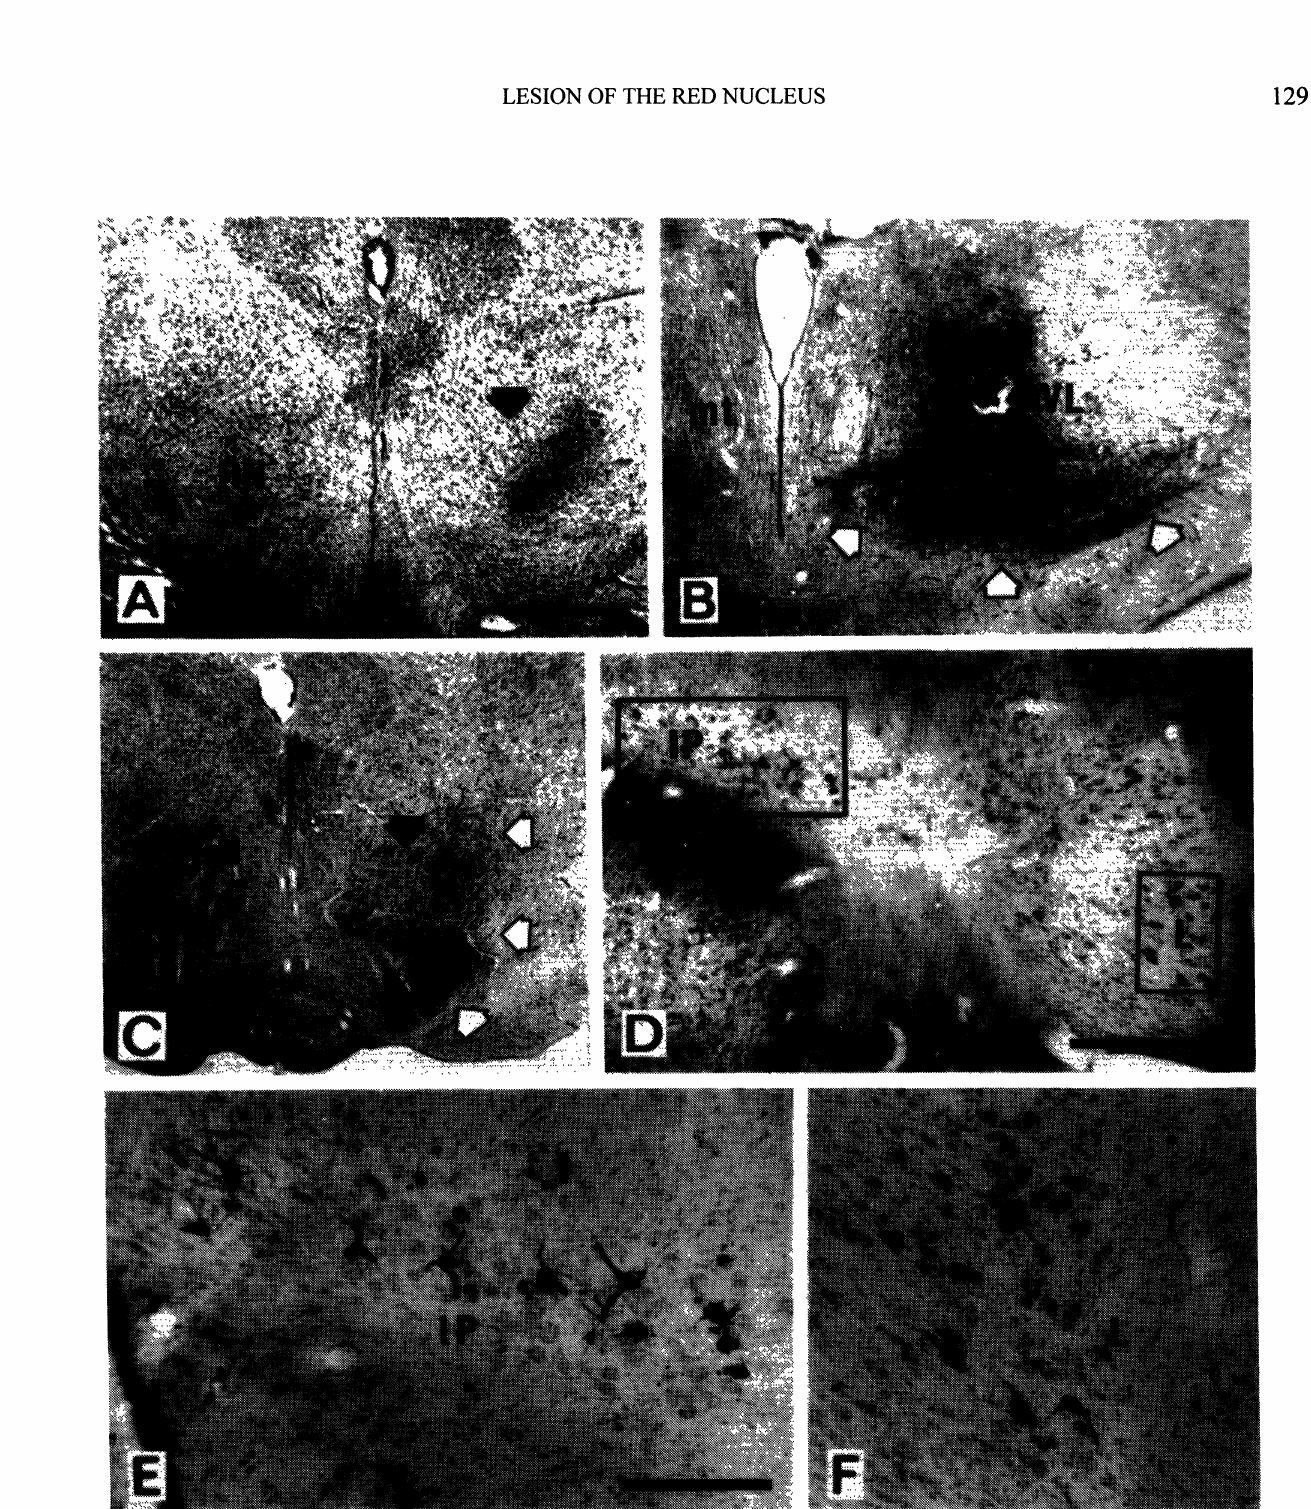
Fig. 5: Microphotographs of the frontal sections ofthe (A,C) rat midbrain, (B) the thalamus, and (D,E,F) cerebellar nuclei. The effects of chemical lesion of RN by injection of (A,C) local quinolinic aid and (B) local microiontophoretic HRP into the VL, on day 7 after chemical lesion. Microphotographs of HRP-labeled efferent neurons of nucleus interpositus (IP) and nucleus lateralis (L) of the cerebellum (D). Magnifications of the insets shown in (D) for IP and L (E and F, respectively). The closed arrowheads designate destroyed neurons of RN; the open arrowheads designate retrogradely labeled cerebello-thalamic fibers passing through RN (C). Section (A) was stained by Nissl’s method; in sections (B to F), the enzyme was histochemically revealed using tetramethyl benzidine. Bar: lmm=500 in A to C, lmm=200 in D; mt mammillo-thalamic